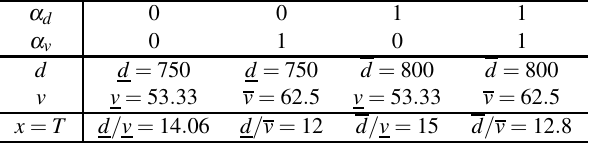
Table 1. Values of variables d , v and x = T for various bor- der values of RDM-variables α d ∈ [ 0 , 1 ] and α v ∈ [ 0 , 1 ] where x means the travel time between City 1 and City 2. α